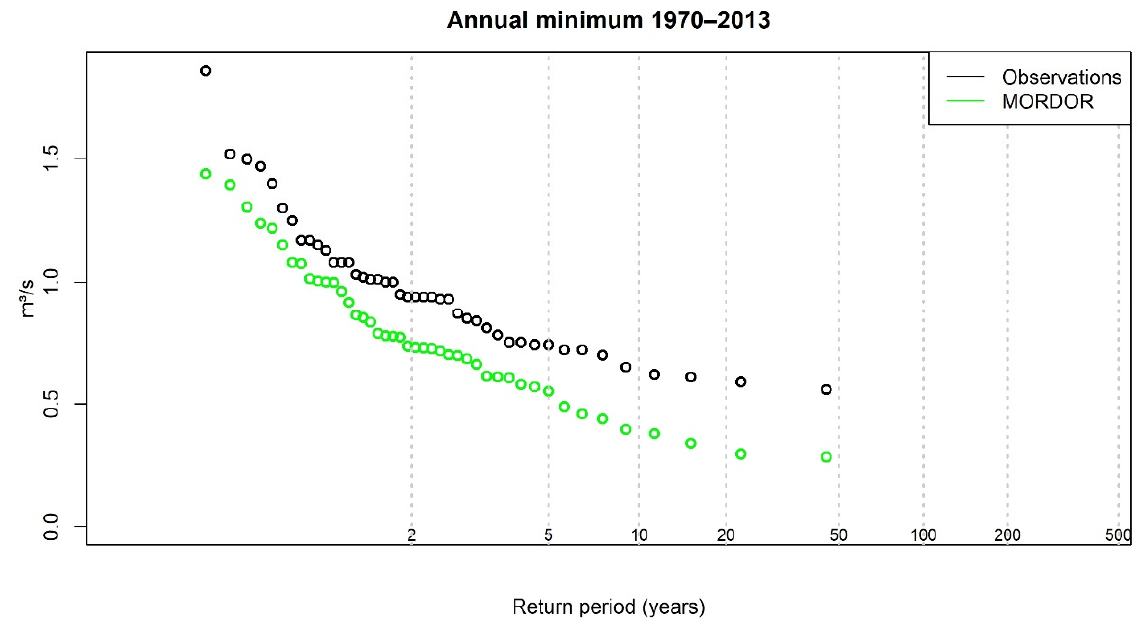
Figure 3. Comparison of the distributions of the lowest flows as observed (black dots) and simulated with MORDOR using observed temperature and precipitation (green dots) over period 1970–2013.